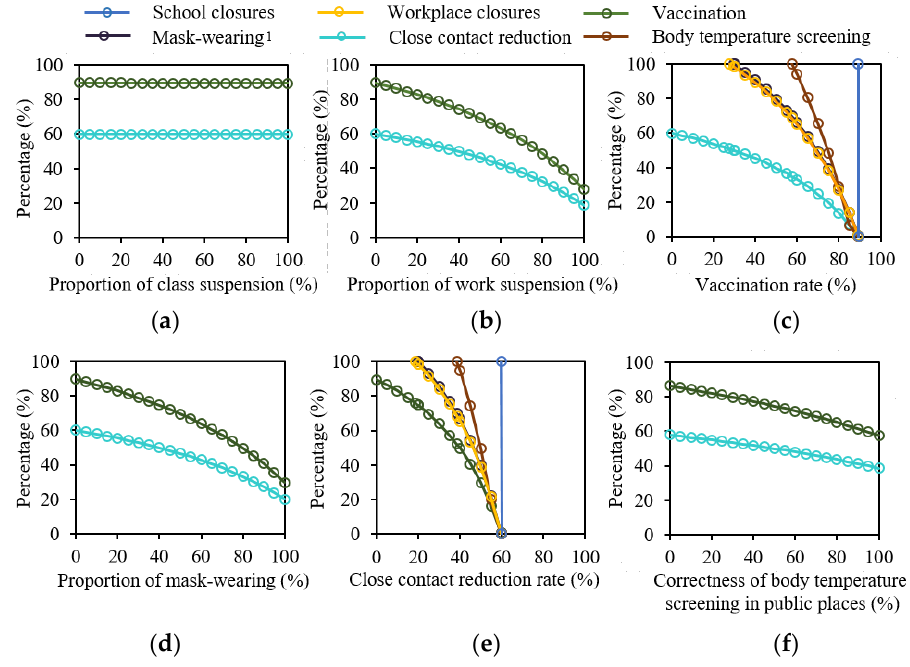
Figure 7. Effectiveness of the combination of two interventions. ( a ) School closures. ( b ) Workplace closures. ( c ) Vaccination. ( d ) Mask-wearing. ( e ) Close contact reduction. ( f ) Body temperature screening in public places. 1 Wearing masks was in schools, workplaces, supermarkets, shopping centers, and public transports.